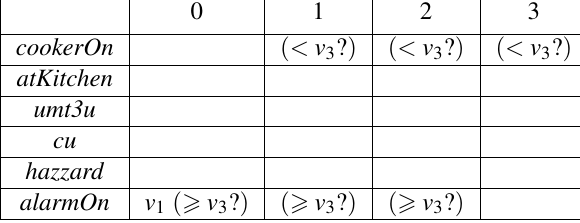
Table 12. The Searching Process of Query ( ¬ cookerOn , 3 , v 3 ) 0 1 2